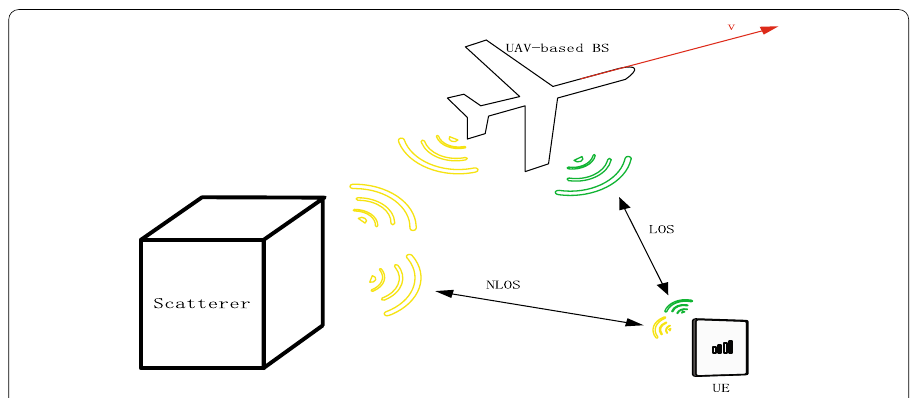
Fig. 1 UAV-enabled BS and UE with LOS and NLOS